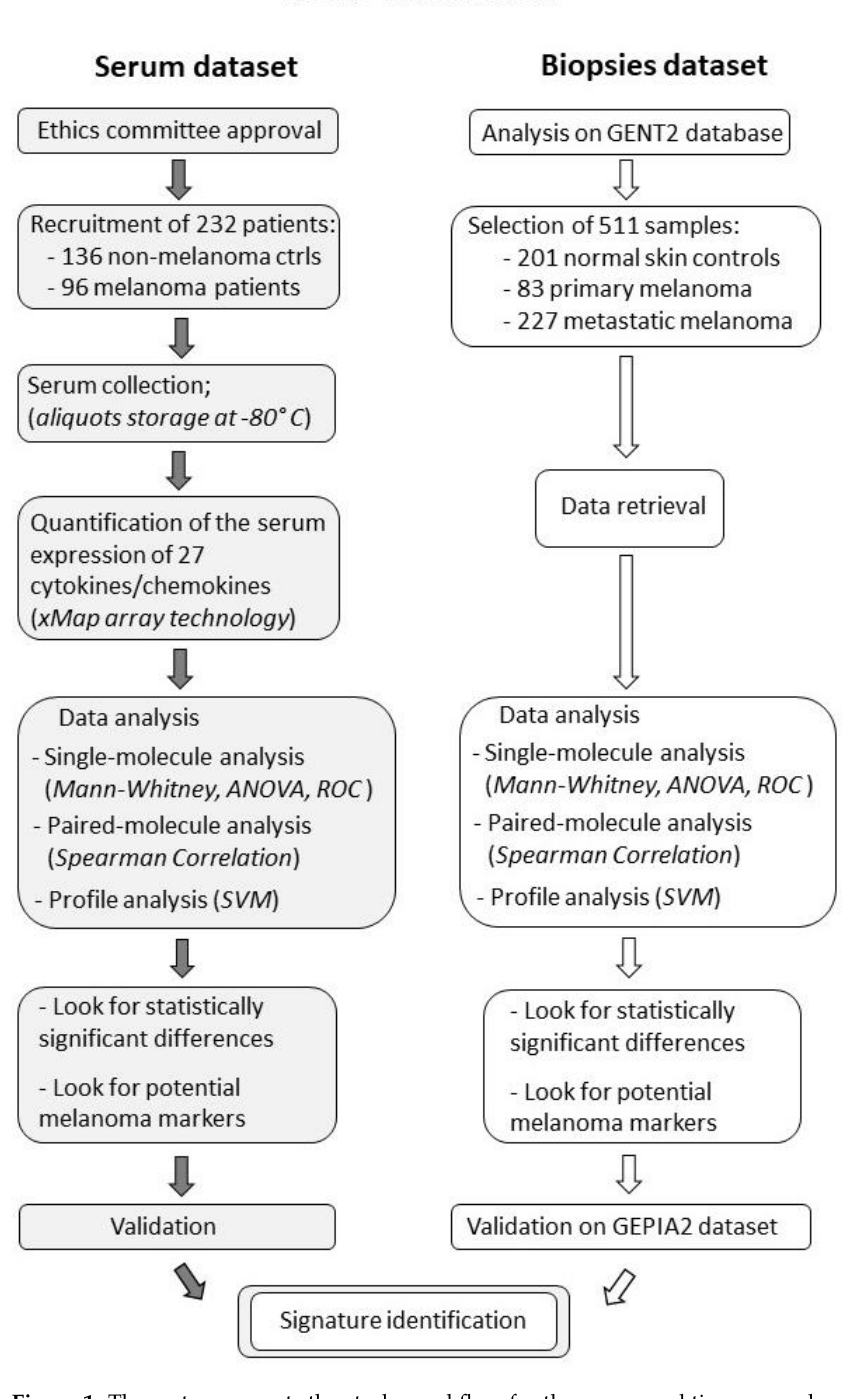
Figure 1. The cartoon reports the study workflow for the serum and tissue samples.